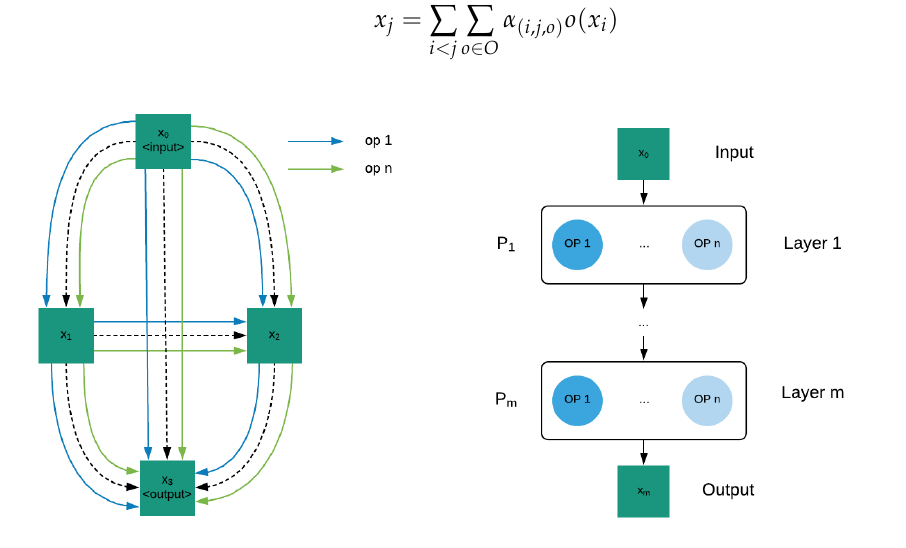
Figure 8. Stochastic super-network ( left ): PC-DARTS, ( right ): FB-Net. Value of each tensor x i can be defined using its predecessors as shown in Equation